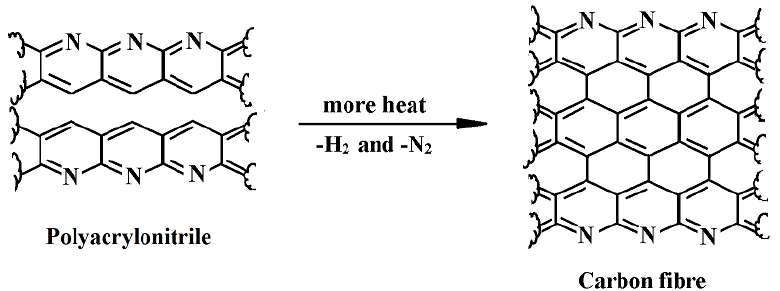
Figure 11. Chemical structure of carbon fiber [102].